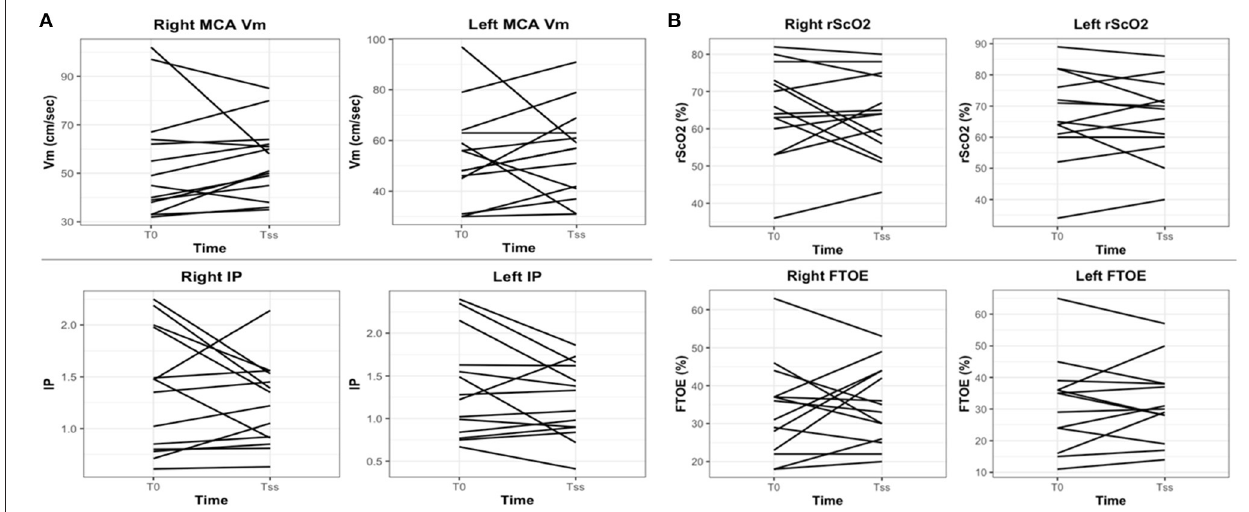
FIGURE 2 | Individual effects of norepinephrine infusion on (A) cerebral perfusion and (B) cerebral oxygenation. Each line represents one patient. cFTOE, cerebral Fractional Tissue Oxygen Extraction; MCA Vm, Middle Cerebral Artery mean velocity; PI, Pulsatility Index; T 0 , beginning of norepinephrine infusion; T ss : steady-state.